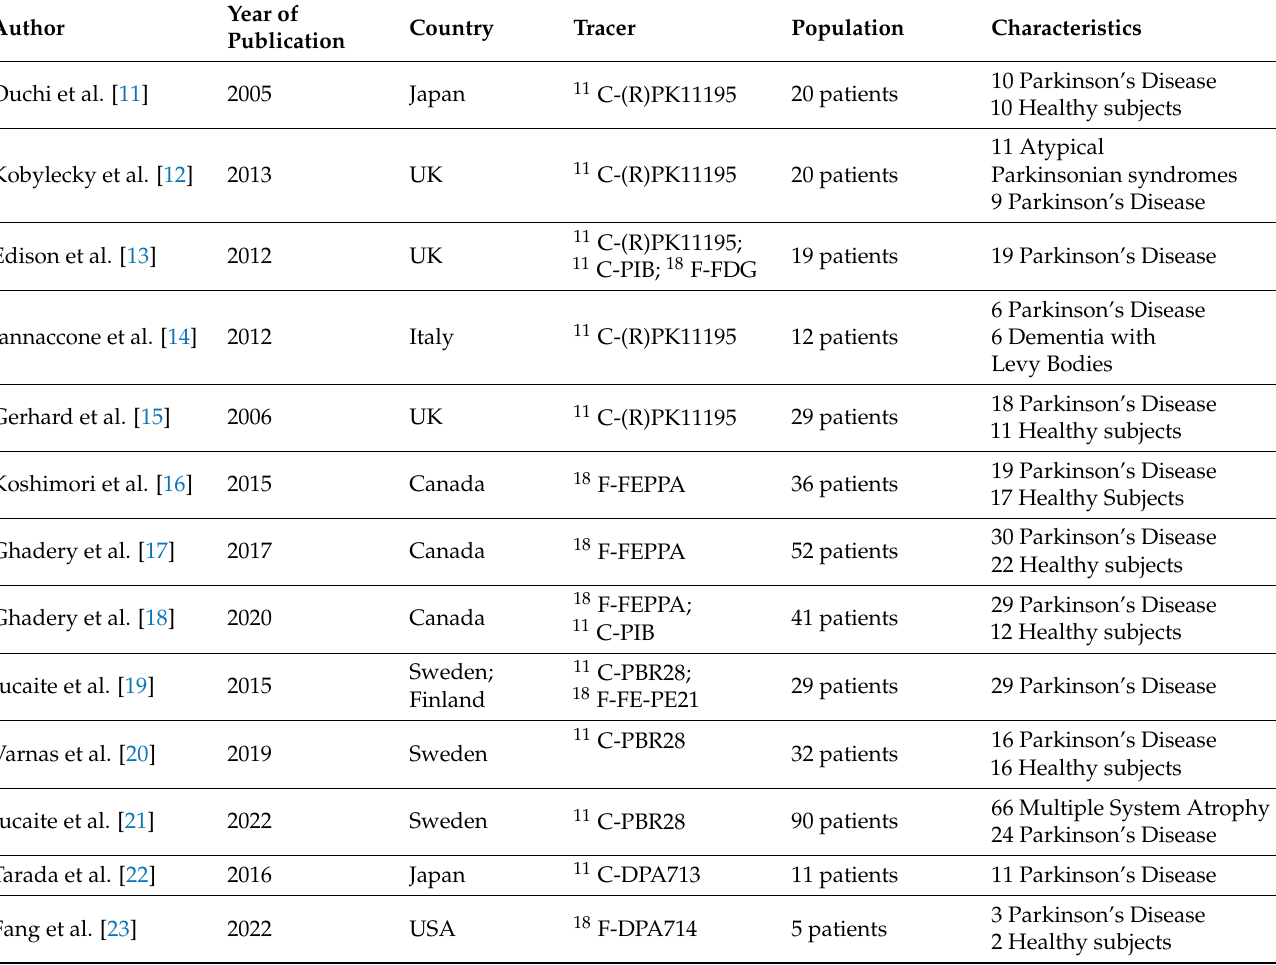
Table 1. Studies